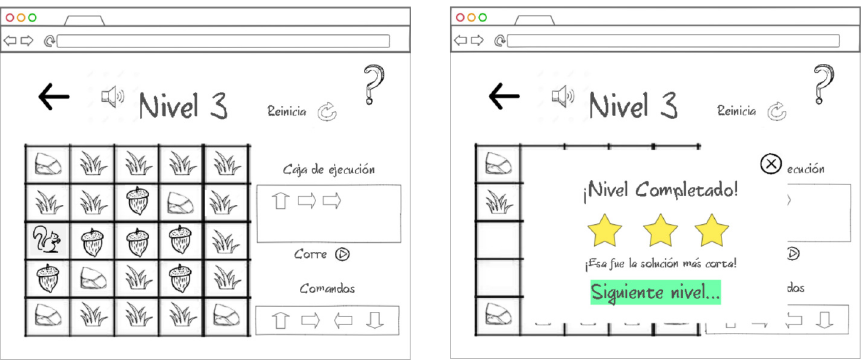
Fig. 7. Interface prototype with the game in